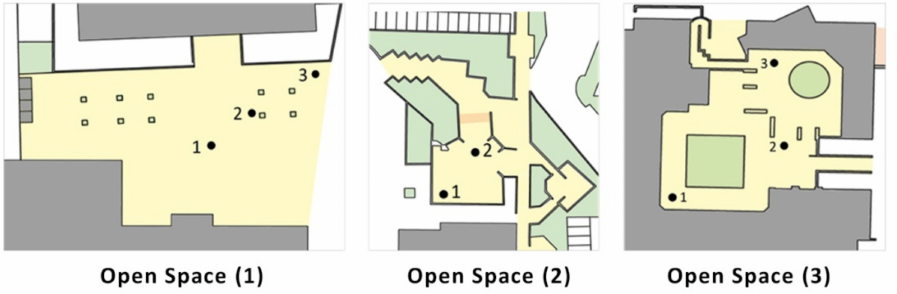
Figure 3. Receptors’ locations in the study areas: open space 1 ( left ), open space 2 ( centre ), open space 3 ( right